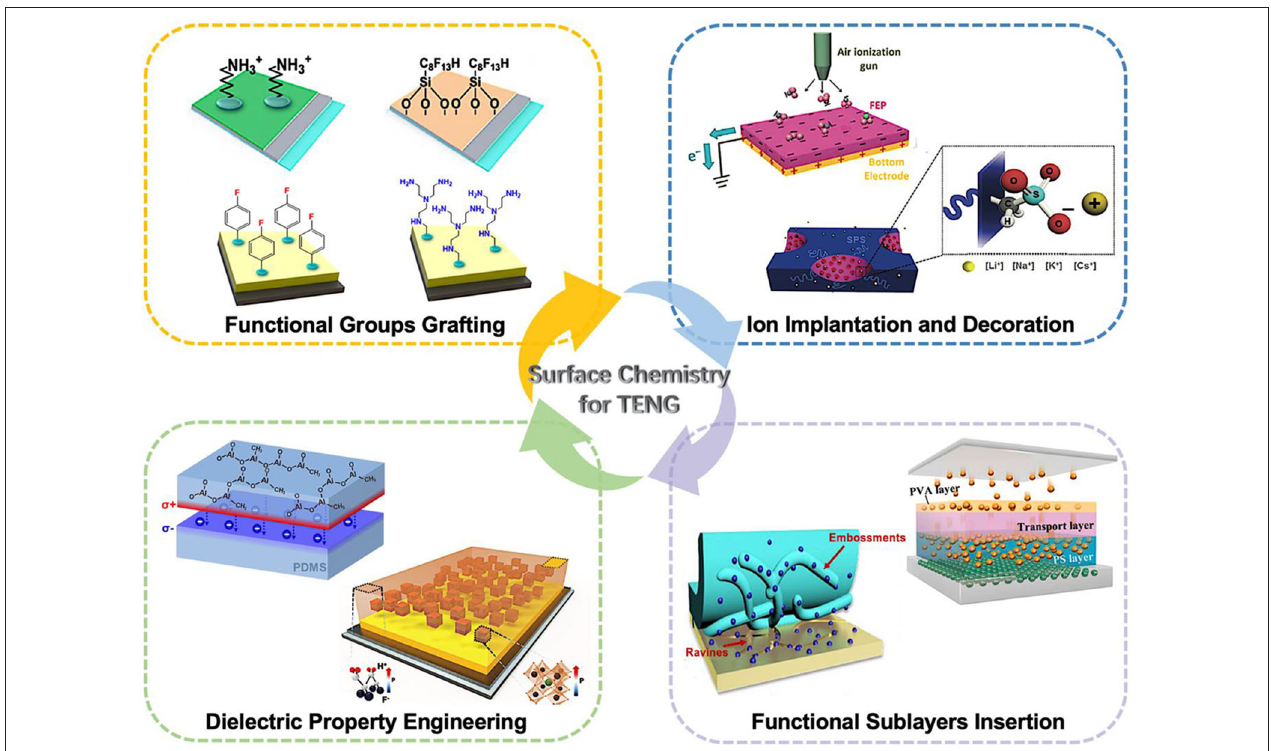
FIGURE 1 | Surface chemistry for high-performance triboelectric nanogenerators. Reprinted with permission from Shin et al. (2017). Copyright 2017 American Chemical Society. Reprinted with permission from Shin and Kwon (2015). Copyright 2015 American Chemical Society. Reprinted with permission from Wang et al. (2014). Copyright 2014 Wiley-VCH. Reprinted with permission from Park et al. (2017). Copyright 2017 WILEY-VCH. Reprinted with permission from Yu et al. (2015). Copyright 2015 Wiley-VCH. Reprinted with permission from Seung et al. (2017). Copyright 2017 Wiley-VCH. Reprinted with permission from Lai et al. (2018). Copyright 2018 American Chemical Society. Reprinted with permission from Cui et al. (2018). Copyright 2018 American Chemical